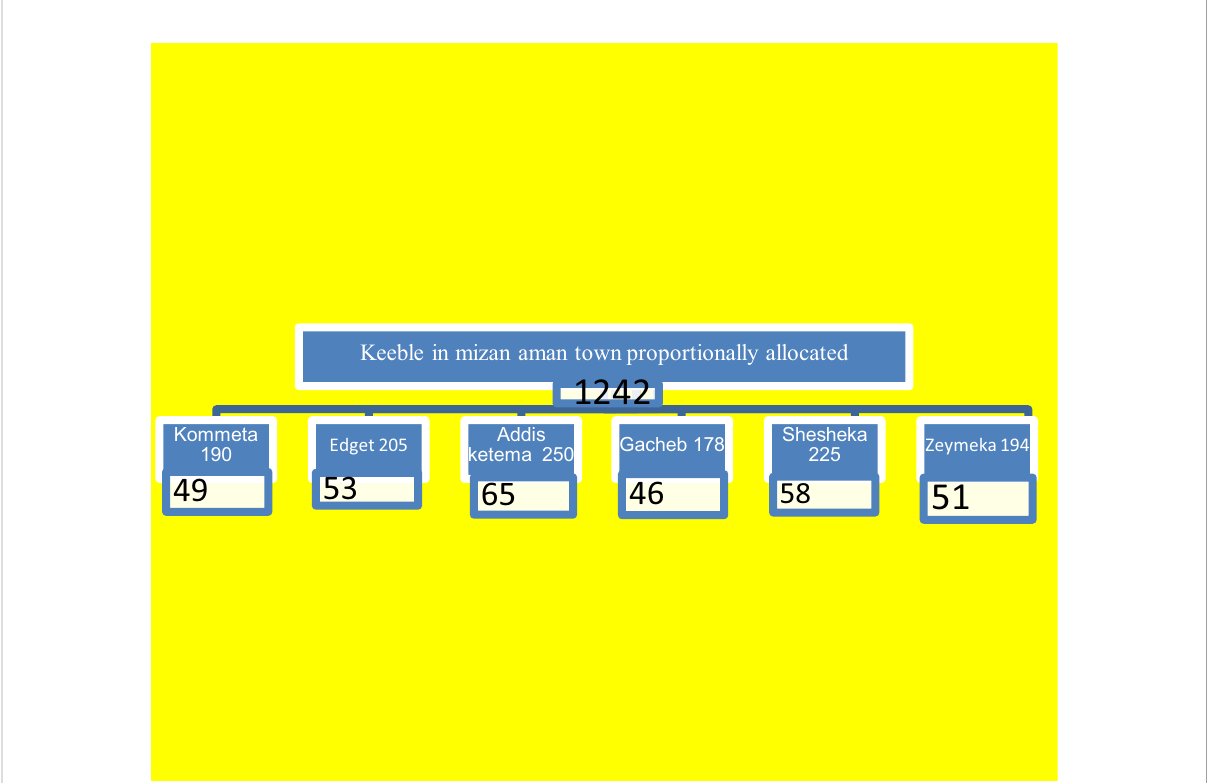
FIGURE 1 Schematic presentation of the sampling procedure in the study of awareness of prostate cancer in men 40 years of age and older in Mizan Aman.